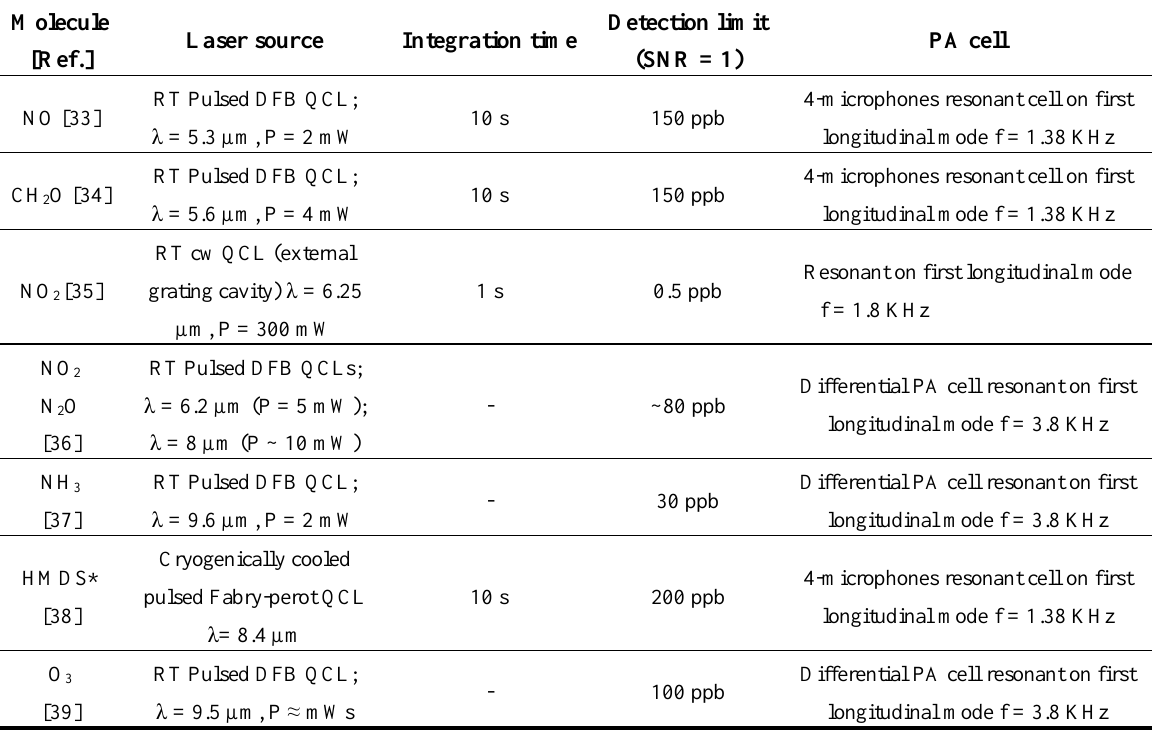
Table 2. PA detection of trace gases with QC